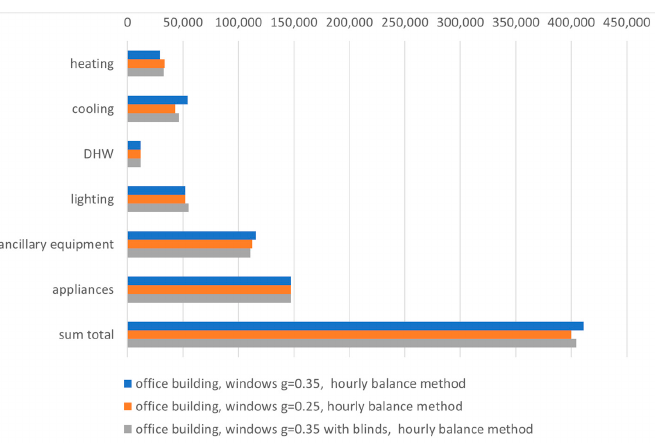
Figure 16. The primary energy demand of glazings and windows with and without solar blinds for the office building.